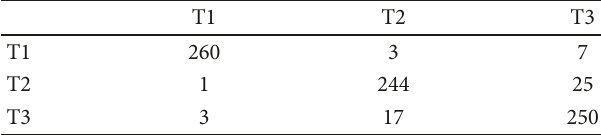
Table 4: Confusion matrix using SVM of a 20 × 20 cell